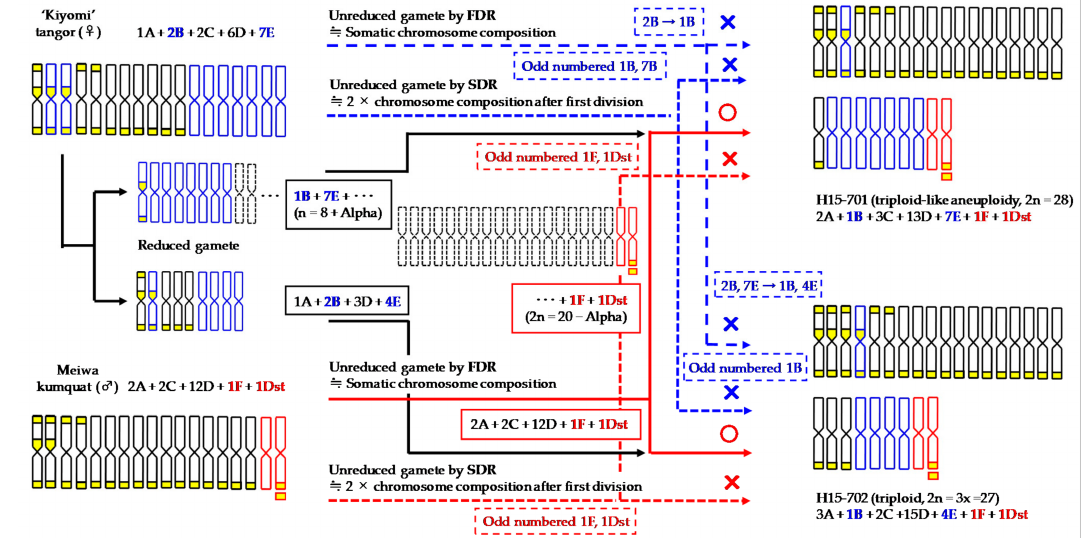
Figure 6. Identification of parental genome construction and unreduced gametes in the intergeneric hybrids between ‘Kiyomi’ tangor and Meiwa kumquat based on these CMA karyotype